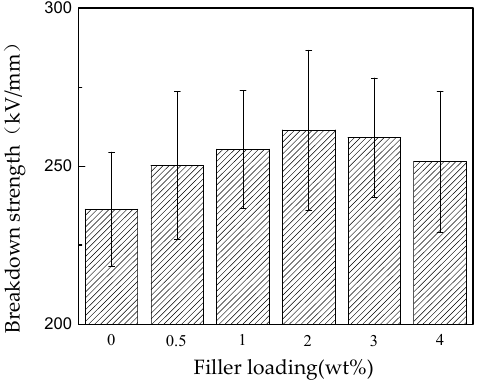
Figure 11. Breakdown strength histogram of RIP with different nanoparticle components.